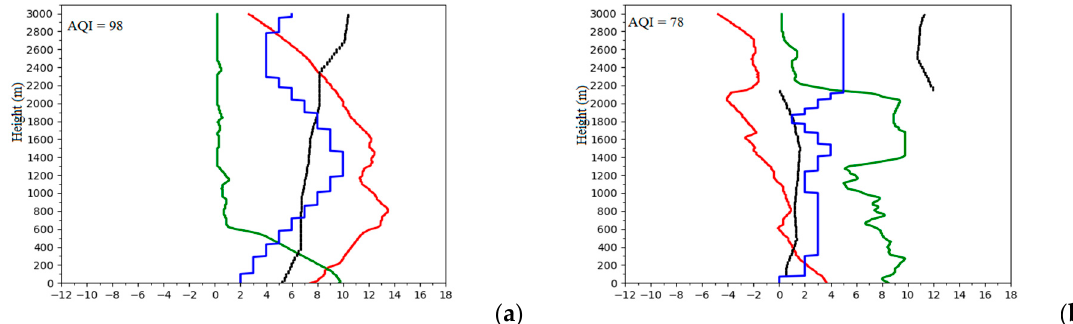
Figure 6. Vertical structure of the atmosphere for ( a ) 18 November 2012, AQI = 98, VI = 4640 m 2 /s ( b ) 11 December 2012, AQI = 78, VI = 1960 m 2 /s. The line and scatter points show the profile of potential temperature (red line, °C), relative humidity (green line, %), wind velocity (blue line, m/s) and wind direction (black scatter plot, c). The number on the x-axis is the result after dividing the relative humidity value by 10 and wind direction angle by 30 while potential temperature and wind speed remain the same.